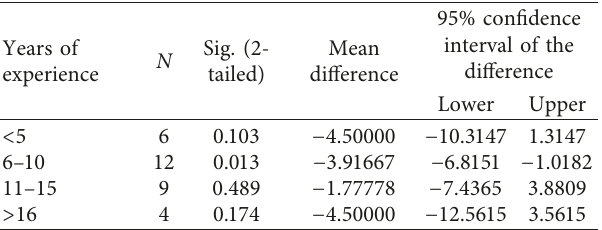
Table 8: Statistic and one-sample t -test for emotional exhaustion with reference to educational level.